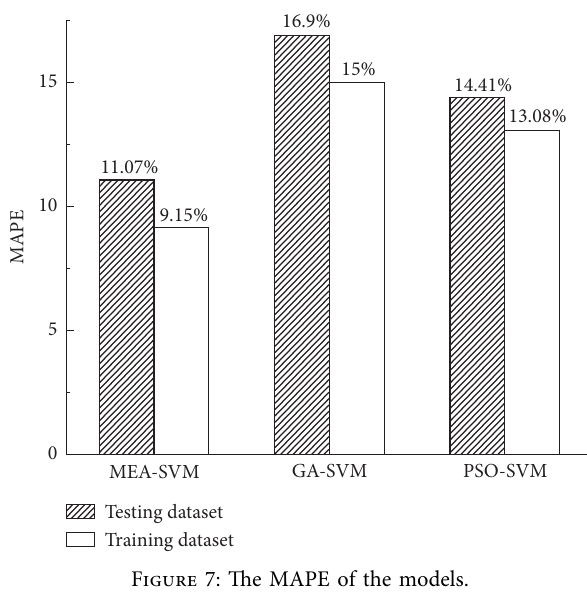
Figure 7: The MAPE of the